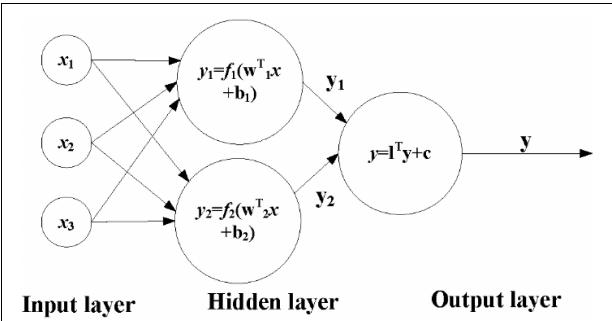
FIGURE 1 | Flowchart of artificial neural network